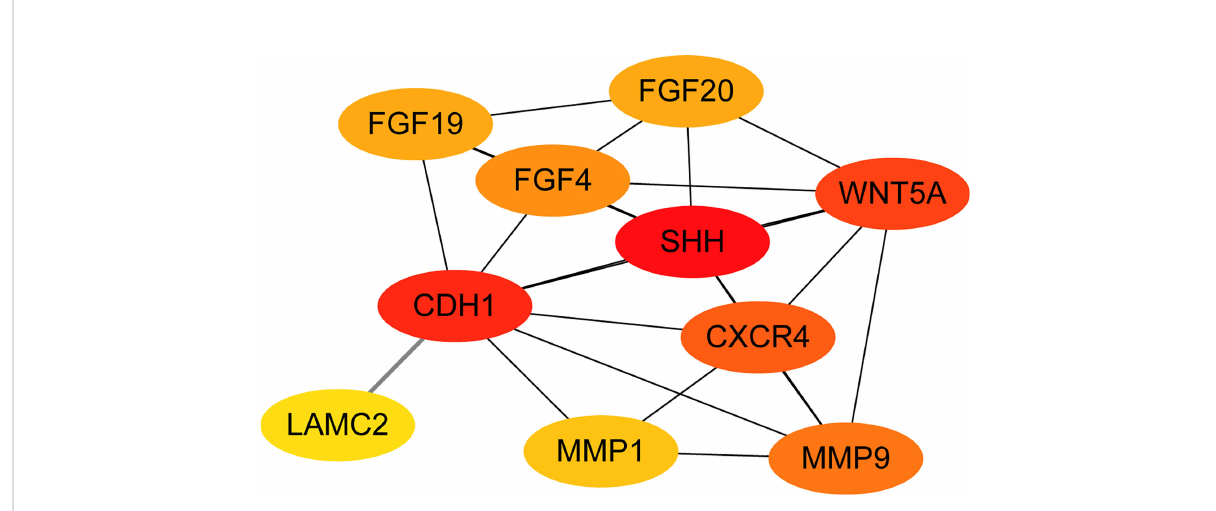
FIGURE 7 The PPI network diagram was constructed from the top 10 key genes among the 15